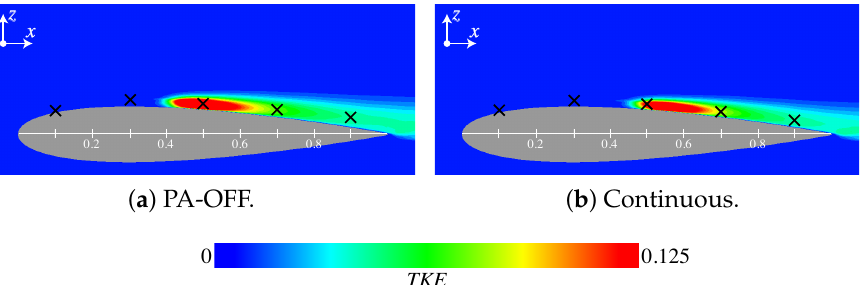
Figure 14. Turbulent kinetic energy (TKE) distributions at α =